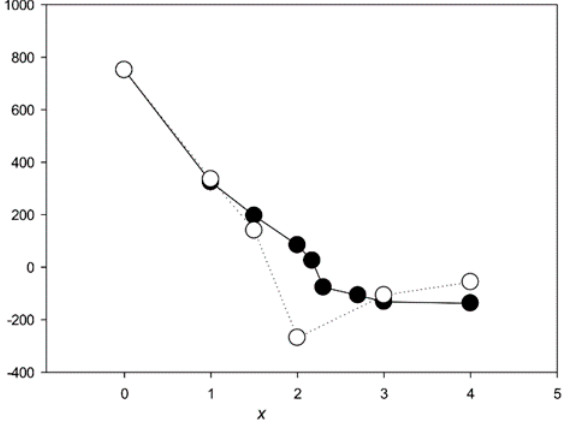
Figure 6. Z ( x ) for MSAs produced by Muscle [18] (black circles) and Kalign [29] (white circles).